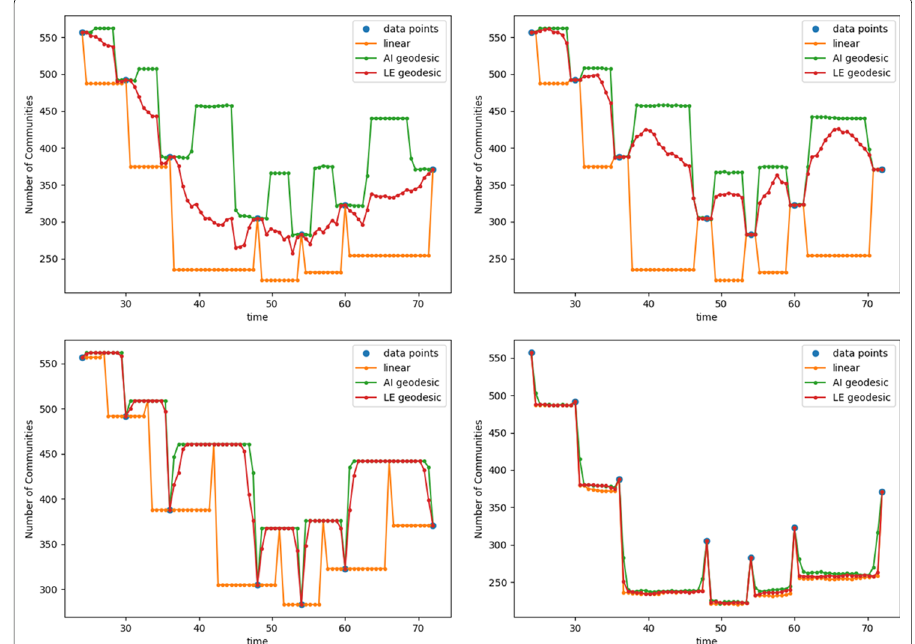
Fig. 8 Number of communities in interpolated proteomics network. The number of communities in the interpolations using thresholds of 0.02 ( topleft ), 0.1 ( topright ), and 0.5 ( bottomleft ) show significant differences between the three interpolations, while using no threshold ( bottomright ) produces similar behaviour for all